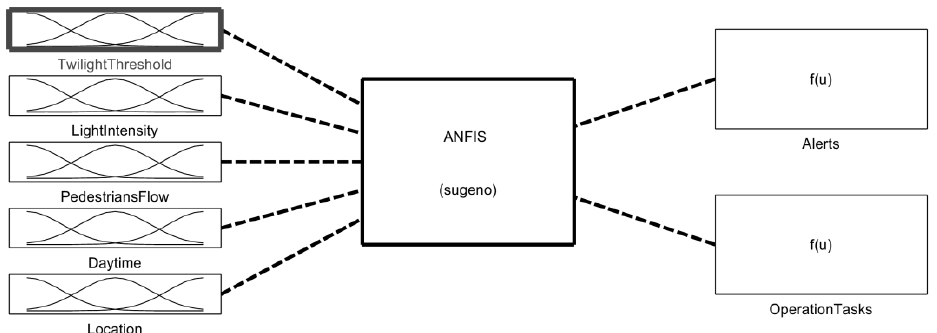
Figure 16. Adaptive neuro-fuzzy inference system